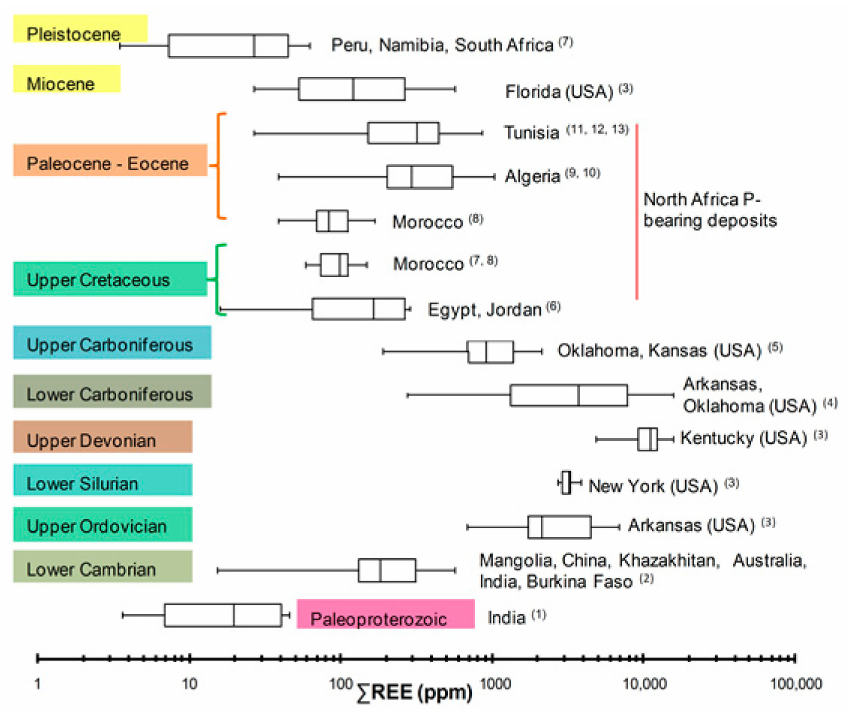
Figure 12. Rare earth elements (REEs) comparison against geological age and several worldwide locations. Data after (1) [88]; (2) [89]; (3) [6]; (4) [90]; (5) [91]; (6) [92]; (7) [93]; (8) [11]; (9) [7]; (10) [13]; (11) [9]; (12) [10]; (13)